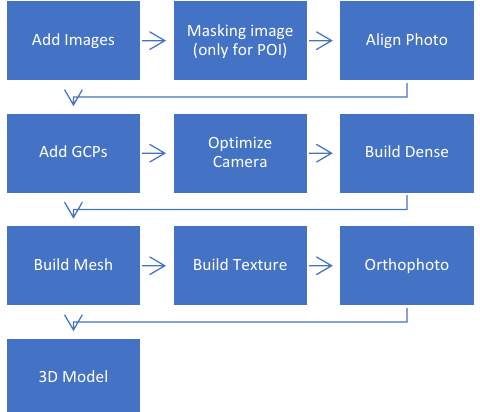
Figure 4. General methodology using Agisoft Metashape